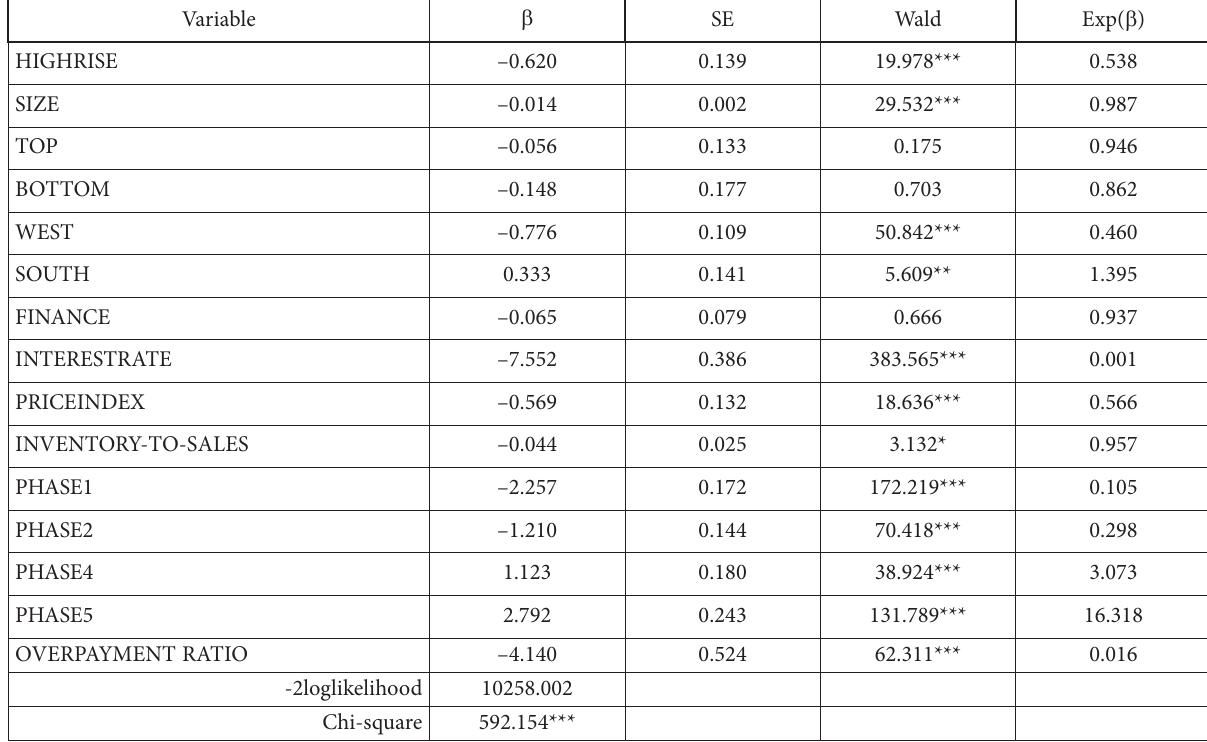
Table 5. Time-on-market estimation